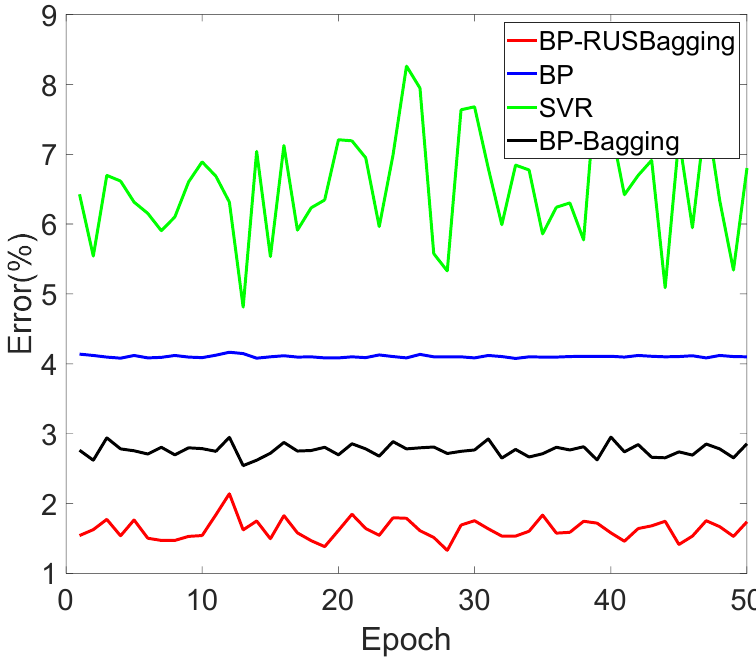
Figure 8. MAPE results of each method on the minority test set.